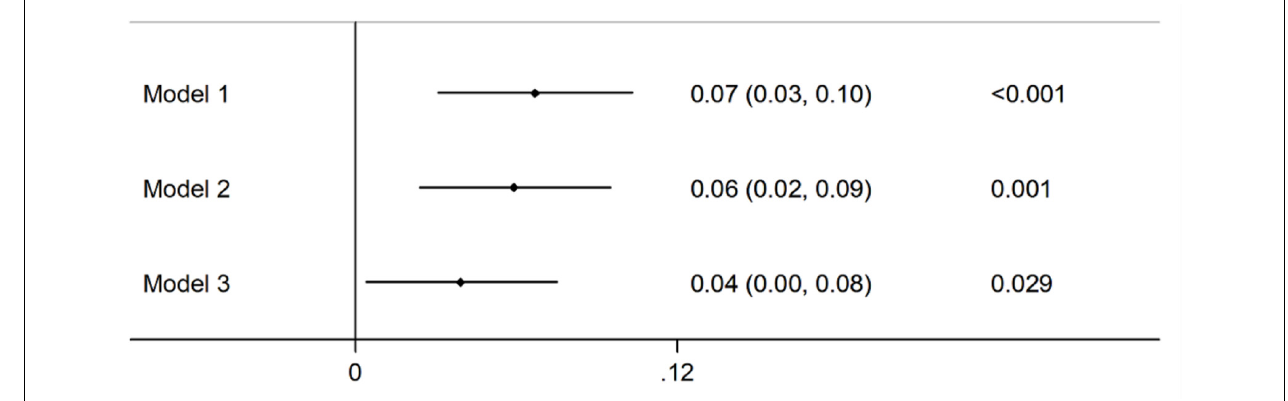
FIGURE 1 | Association of childhood neighborhood quality (CNQ) and cognitive function in adults. Model 1: unadjusted; Model 2: adjusted for age, sex; Model 3: adjusted for age, sex, body mass index (BMI), education, marital status, smoking, drinking, exercise, family income, urban, and depressive symptoms.